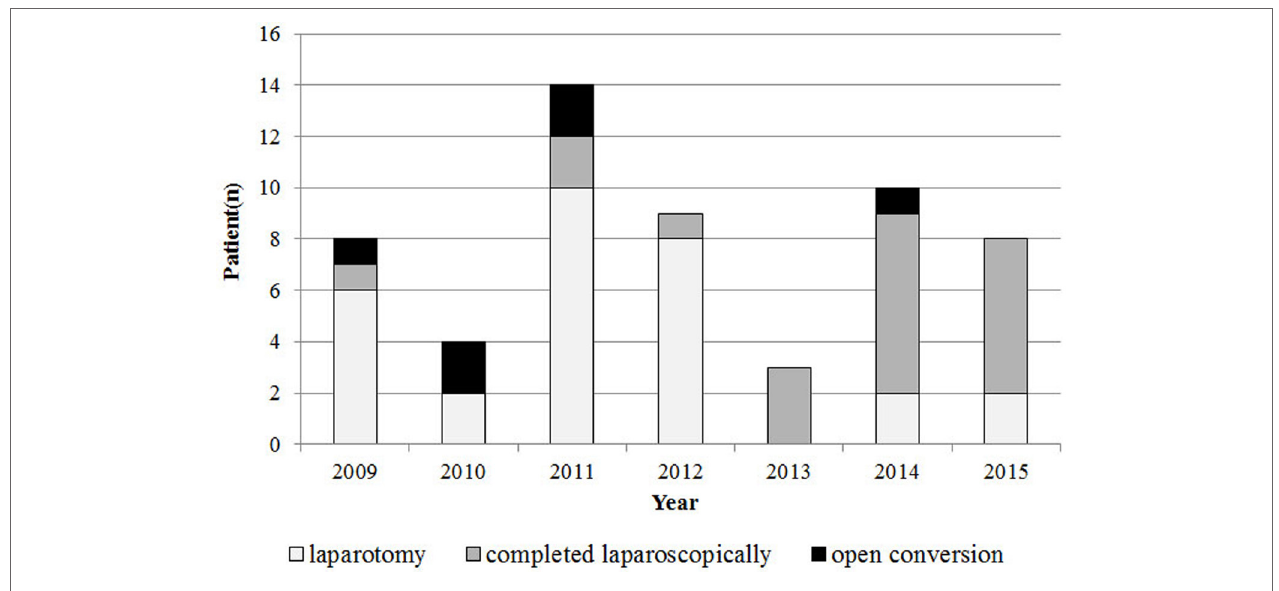
FigUre 3 | Laparoscopic and open repair by